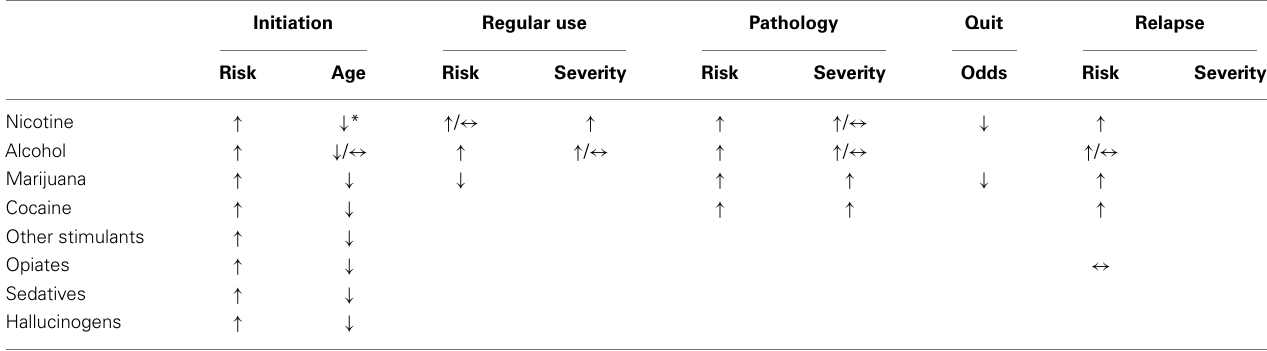
Table 2 | Relationships between stressful events and stages of addictions divided by substance type .